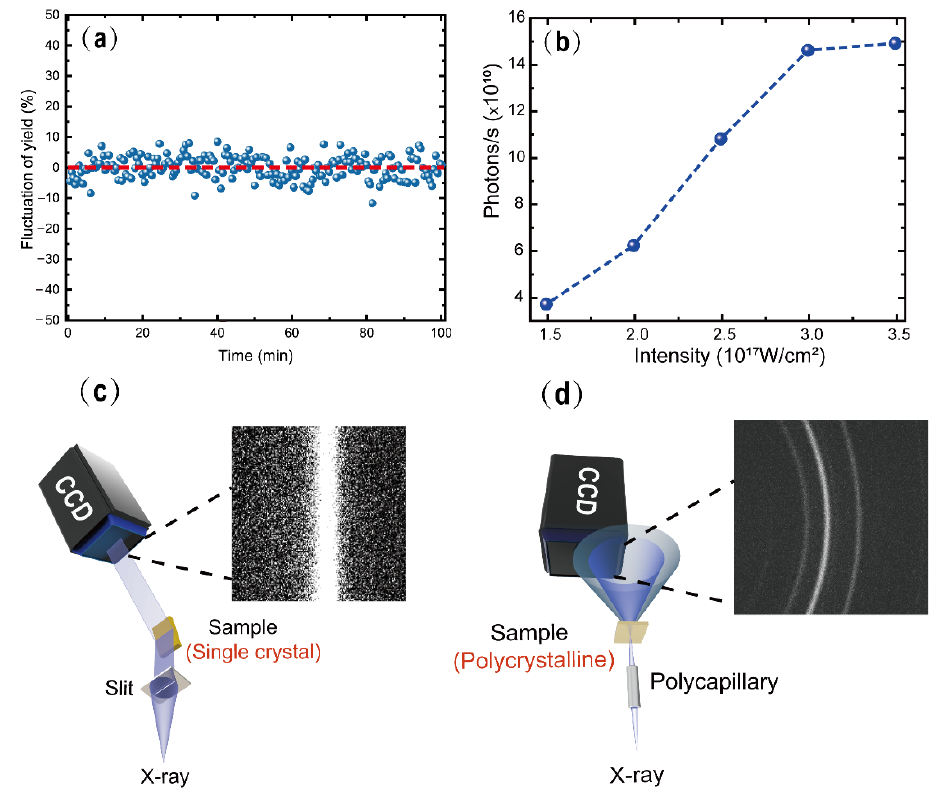
Figure 2. ( a ) The fluctuation of generated Cu-K α X-ray flux within 100 min (blue dot) corresponding to the average output (red line). ( b ) The laser pump intensity dependence of the generated X-ray photon flux. ( c ) The reflection geometry of X-ray diffraction, in which the generated X-ray is passing through a tantalum slit and diffracted off a single-crystal Au film. The integration time of the measured diffraction pattern is 20 s. ( d ) The transmission geometry of X-ray diffraction, in which the generated X-ray is collected by a polycapillary X-ray optics and then diffracted off a polycrystalline Cu tape. The integration time of the measured diffraction pattern is 300 s.